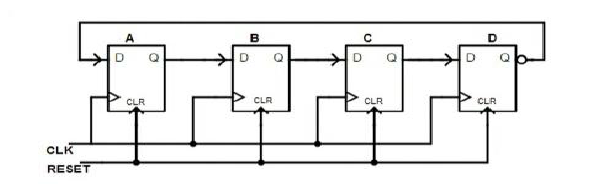
Figure 2 Schematic of Johnson